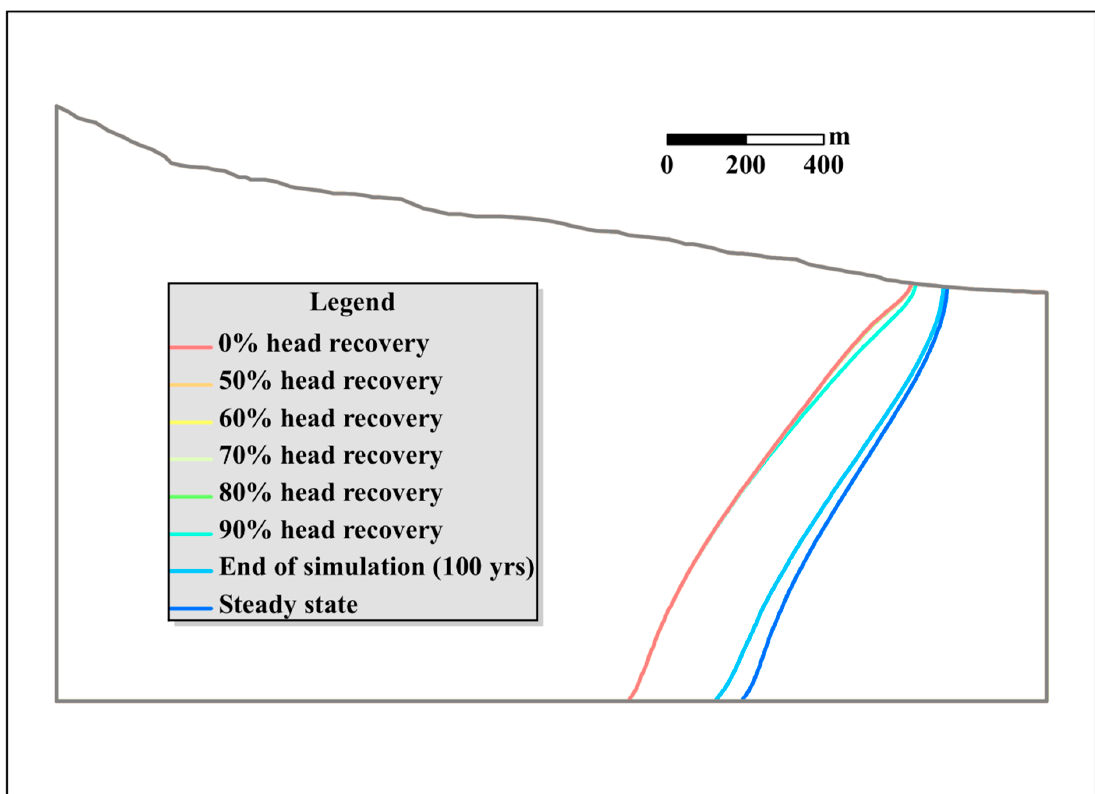
Figure 7. Contours of 1000 mg/L TDS for different percentages of head recovery for the new base case.